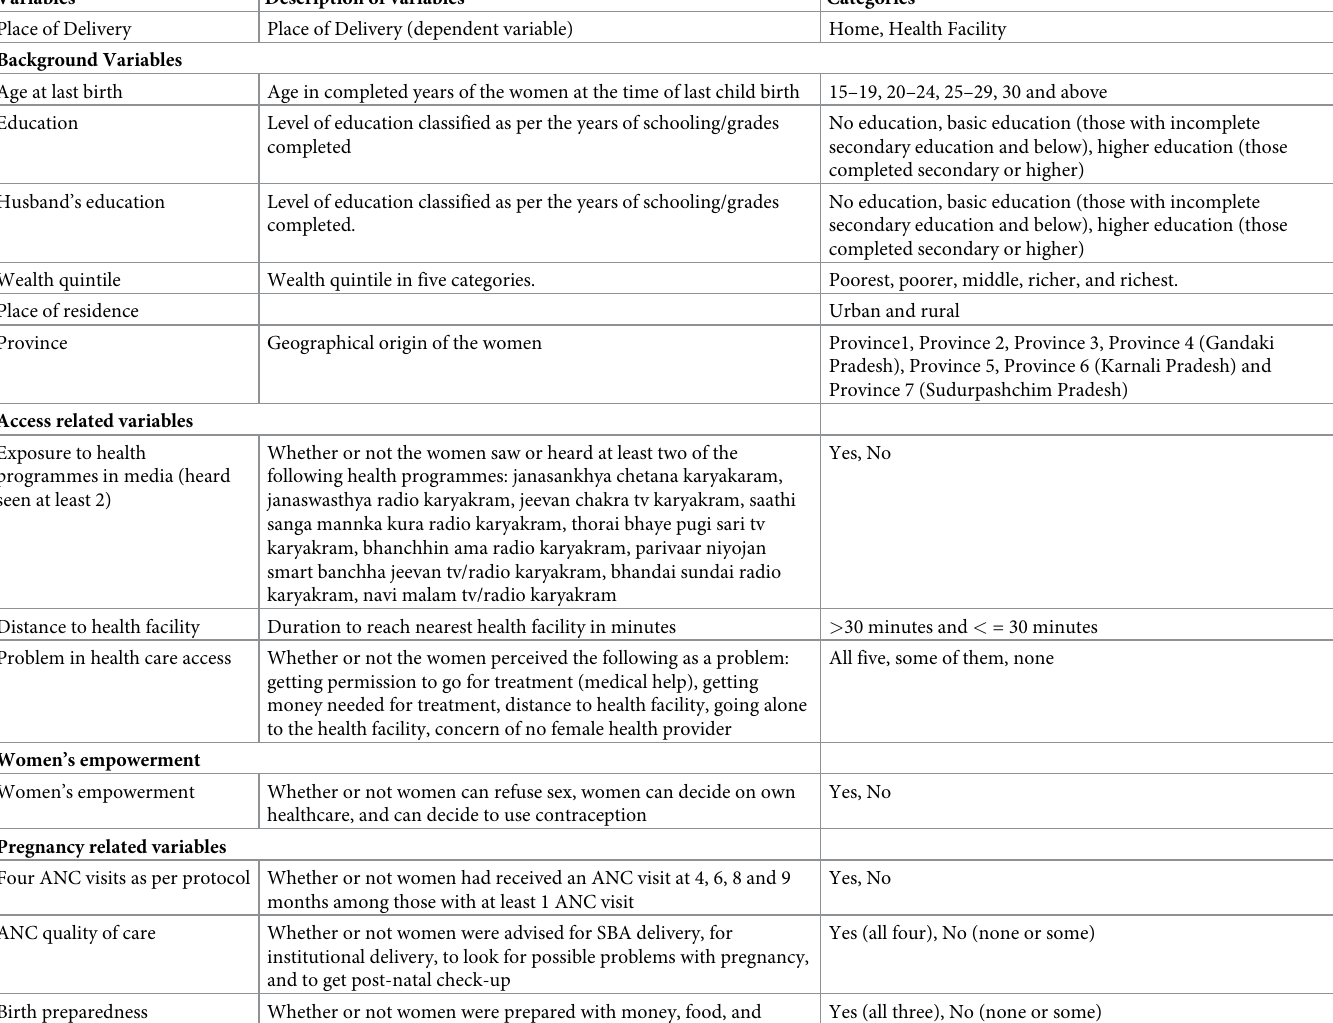
Table 2. List of study variables and their operational